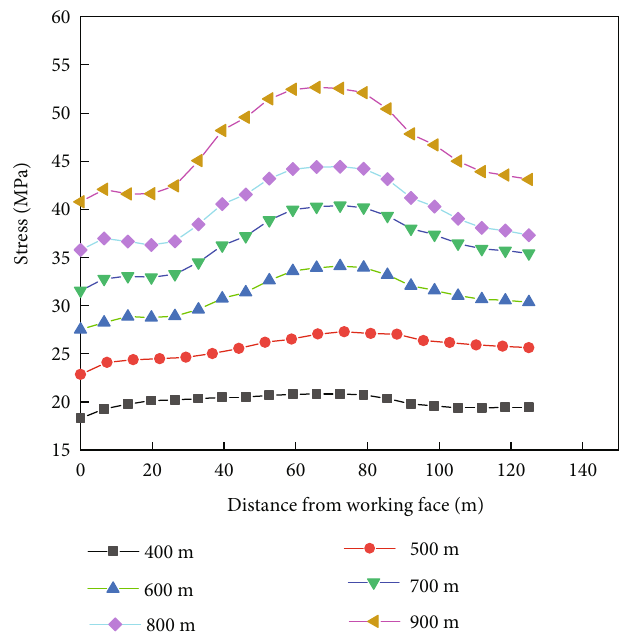
Figure 15: Vertical stress distribution curve on coal pillar with di ff erent buried depths.